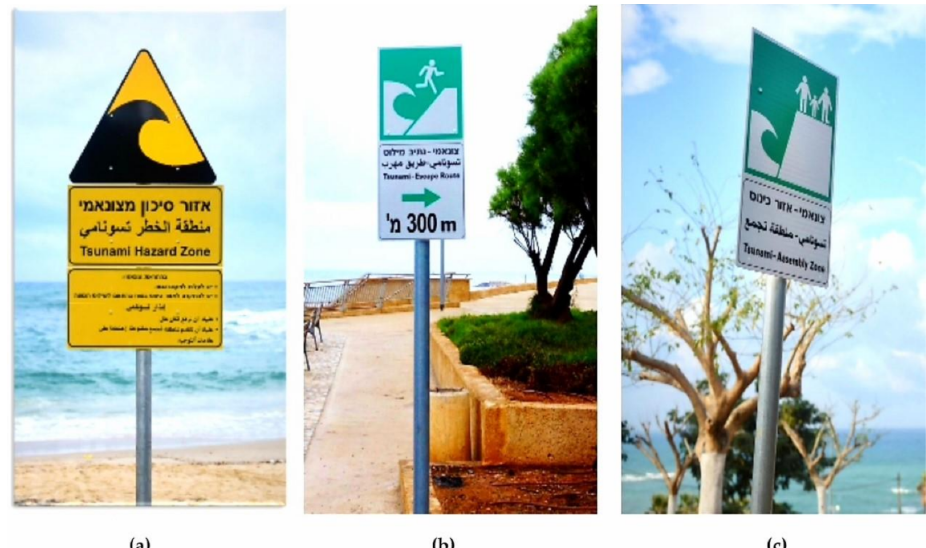
Figure 2. Tsunami hazard road signs installed along the Mediterranean coast of Tel-Aviv, Israel: ( a ) hazard zone; ( b ) escape route and distance to the assembly zone; and ( c ) assembly point. Pho- tographs by A.Y., Tel Aviv, 2016.